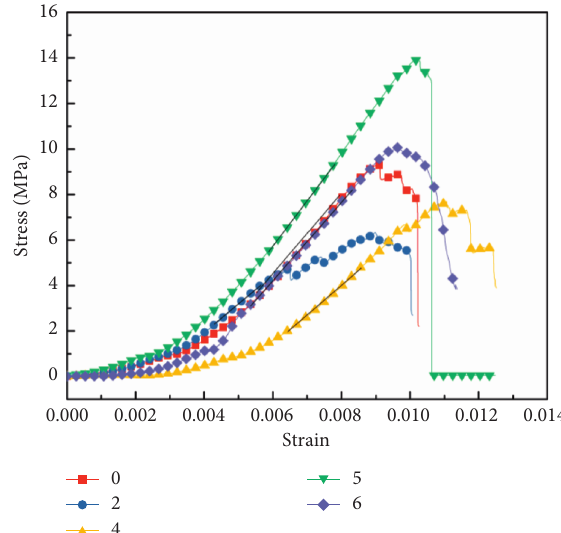
Figure 8: Stress-strain relationship of coal samples under uniaxial